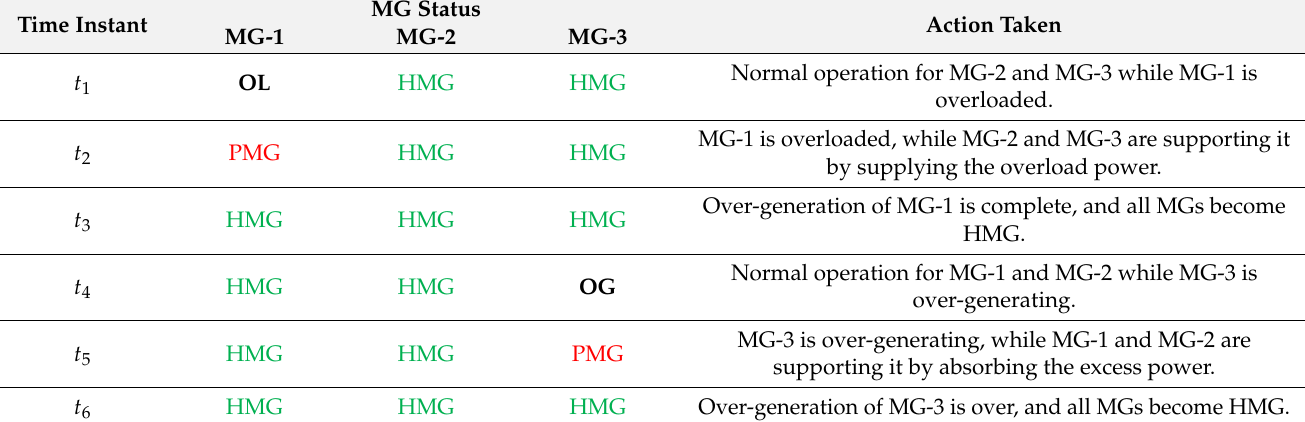
Table 1. Events applied to MGs in case study1 at different intervals for the overloading